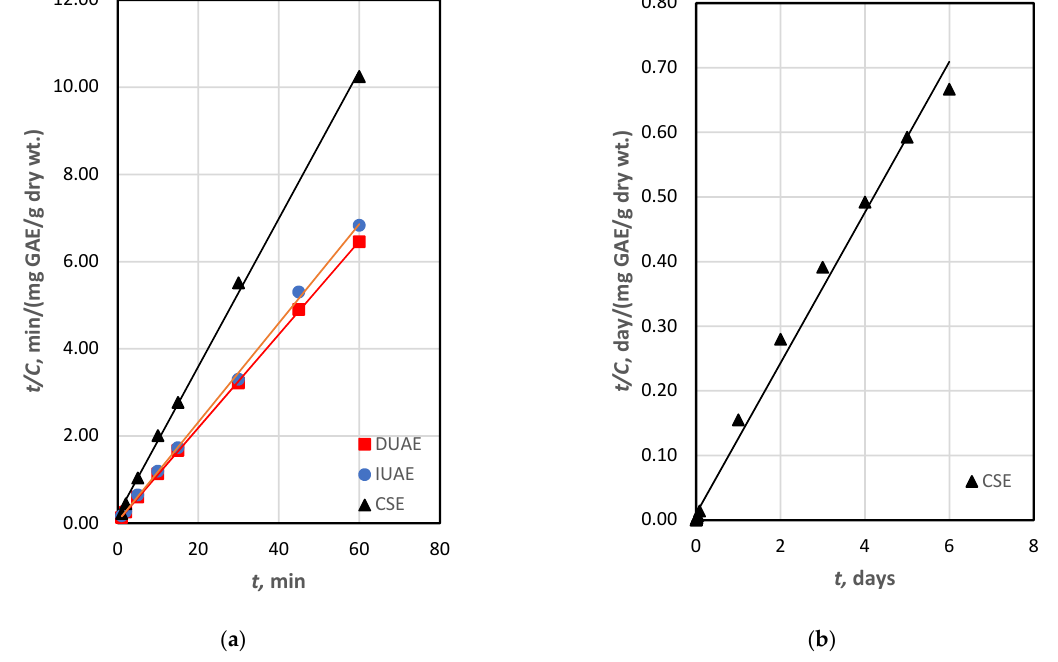
Figure 2. Curve fitting quality using Equation (1) to fit experimental data shown in Figure 1. The intercept of each curve on the y-axis is k 1 and the slope of the curve is k 2 . The values of k 1 and k 2 are given in Table 1. ( a ) Within the first 60 min of extraction, and ( b ) For short duration. Table 1. Parameters obtained by fitting the Peleg model with experimental data shown in Figure 1.